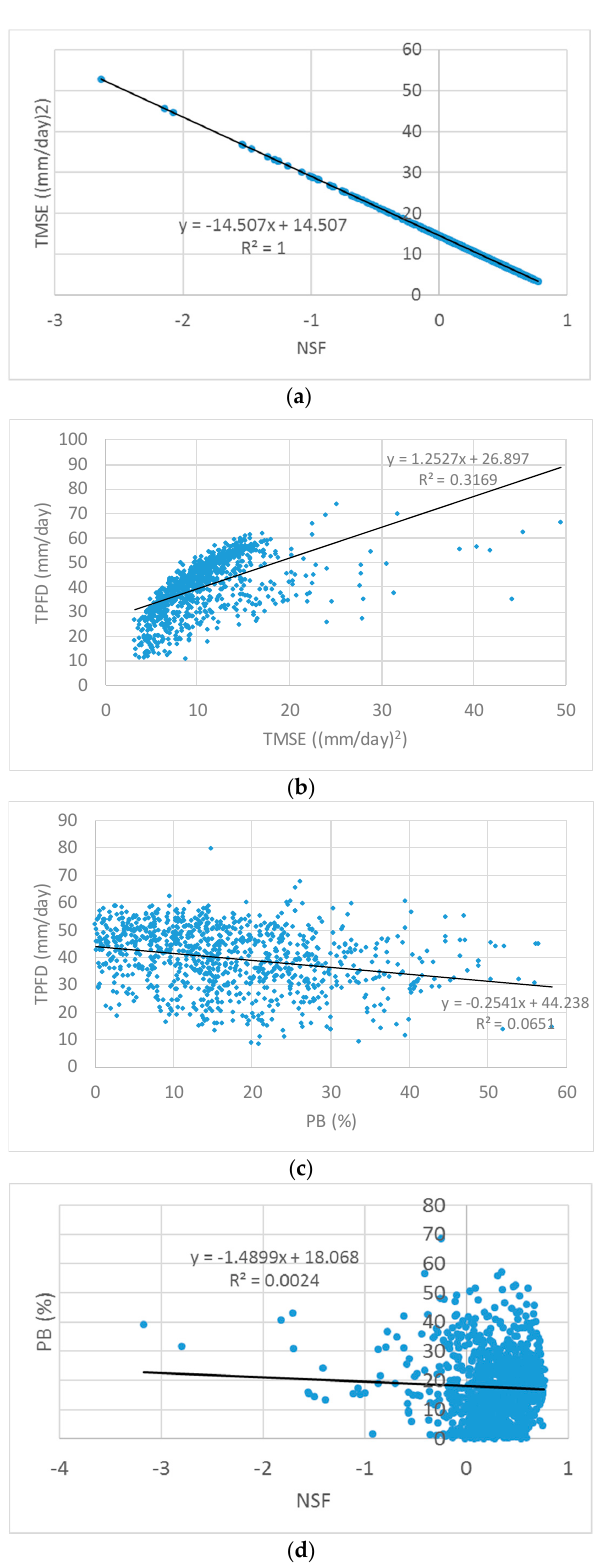
Figure 6. Three representative plots showing 1000 randomly generated points in the two-objective space: ( a ) Nash–Sutcliffe Measure (NSF) versus Total Mean Squared Error (TMSE); ( b ) TMSE versus Three Peak Flow Difference (TPFD); ( c ) Percent Bias (PB) versus TPFD; and ( d ) NSF versus PB.